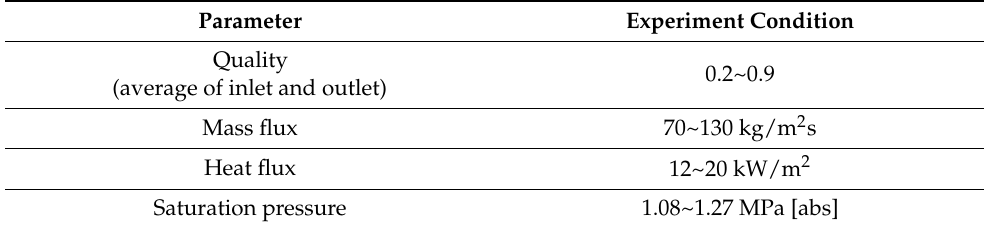
Table 3. Summary of experimental